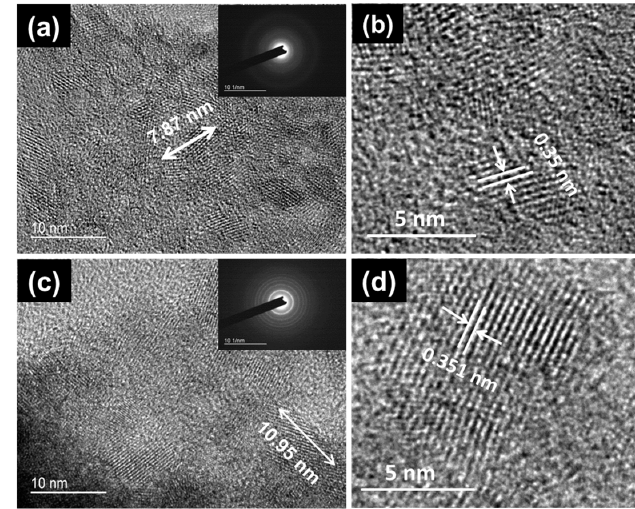
Figure 2. HRTEM images of ( a , b ) 5% TiO 2 and ( c , d ) 10% TiO 2 . Insets in ( a , c ) show the corresponding SAED.